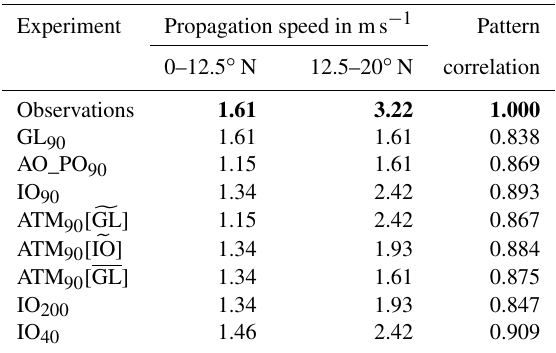
Table 2. Propagation speeds indicated by the green lines in Figs. 6 and 14; pattern correlation between OLR lag correlations in the same figures and for observations (Fig. 6a). Bold text indicates ob-